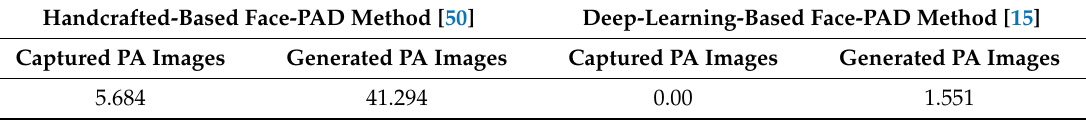
Table 11. APCERs of PA images using di ff erent face-PAD methods (unit: